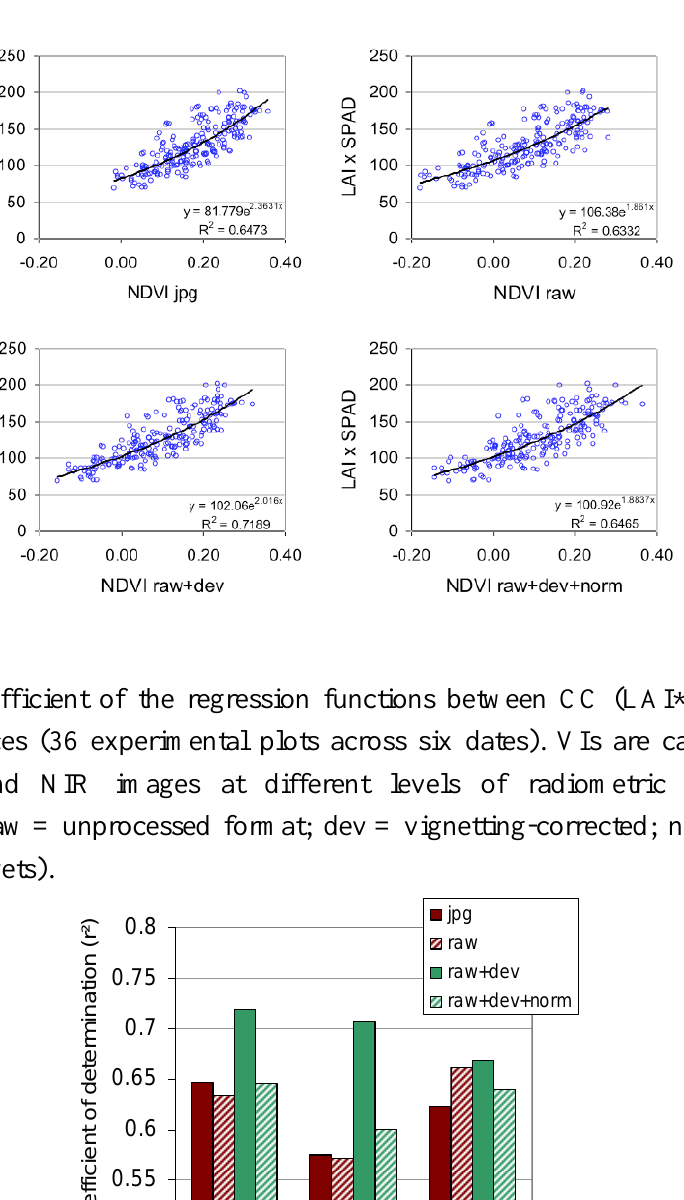
Figure 13. Fitted exponential functions between the Chlorophyll Content (LAI*SPAD) and NDVI for the 36 experimental plots across six dates. NDVI is calculated from the Red and NIR images at different levels of radiometric corrections (jpg = JPEG format; raw =